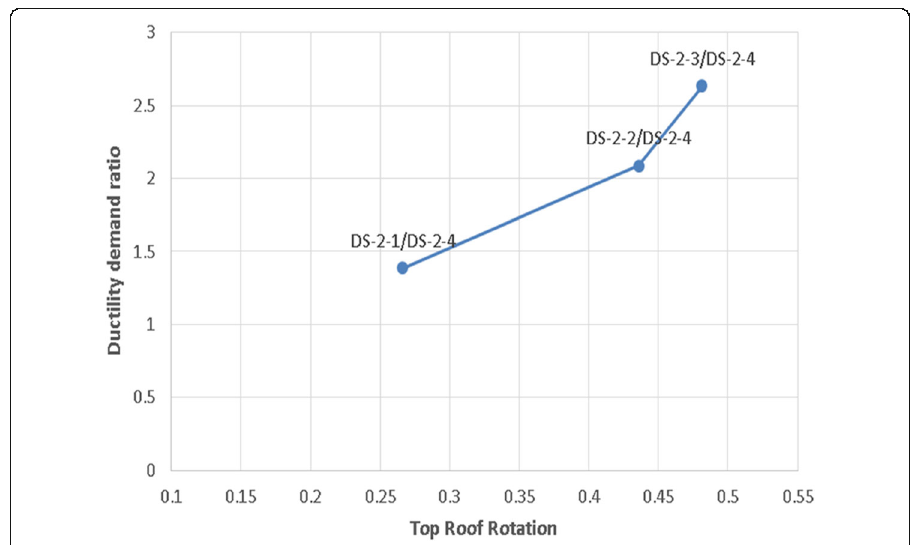
mass for (DS-2-1, DS-2-2, and DS-2-3)